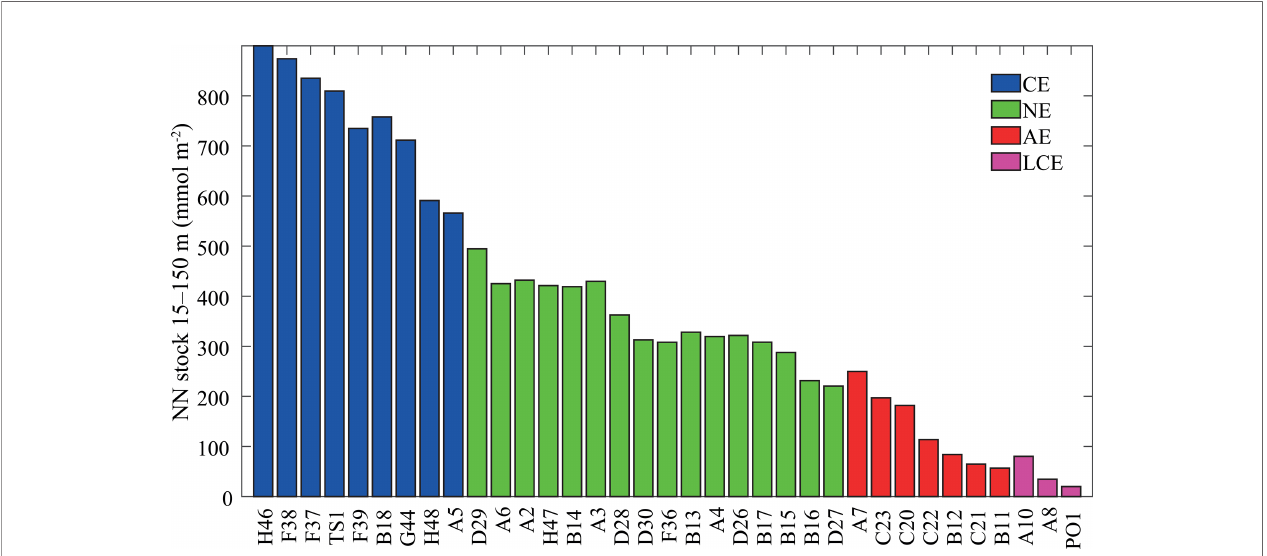
FIGURE 10 | Depth-integrated NN from 15 to 150 m (NN int-150 , mmol m -2 ) of pro fi les interpolated by the PCHIP method. The blue, green, red, and magenta bars correspond to the cyclonic (CE), no eddy (NE), anticyclonic (AE), and Poseidon groups, respectively. The stations were ranked based on NN int-200 from highest (H46) to lowest (PO1) as in Figure 4